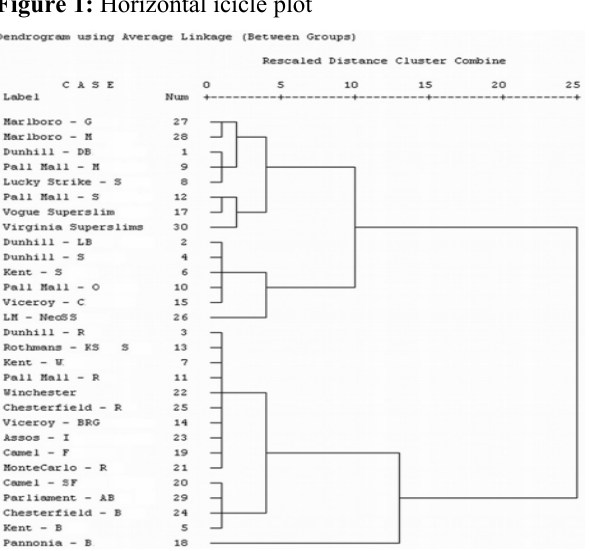
Figure 2: Dendrogram (Average linkage between